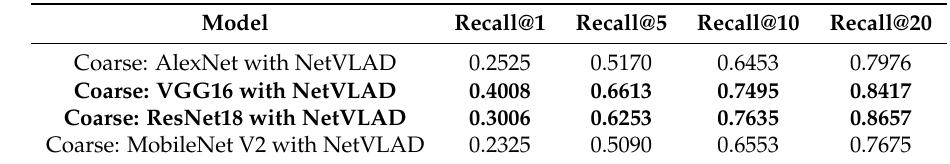
Table 3. Localization results of coarse stage on the summer night subset of MOLP dataset [56]–Backward as query, Forward as